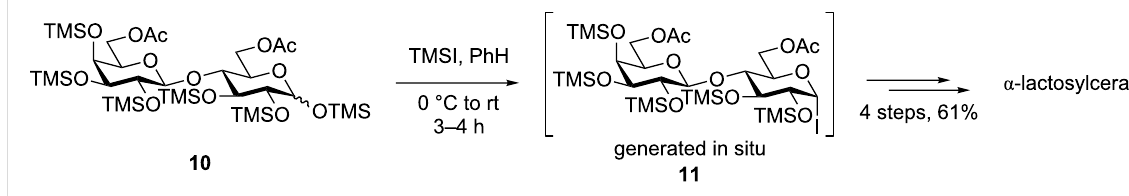
Scheme 3: Glycosylation with thioglycoside 7 .